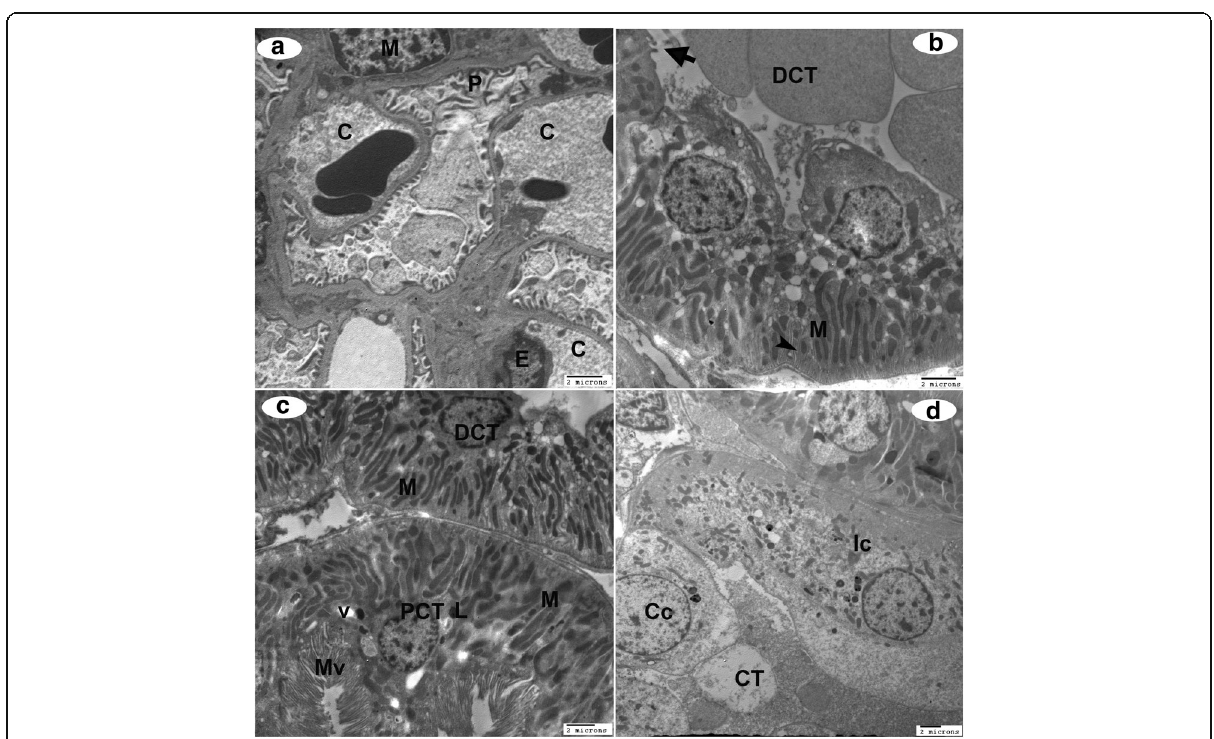
Fig. 2 Electron micrographs of the control rat cortex. a Glomerulus with several capillary loops (C), mesangial cell with dense matrix (M), and several podocyte processes (P) and endothelia cell nucleus (E). b DCT with elongated mitochondria (M), basal enfolding (arrow head), and very few microvilli (arrow). c PCT with characteristic microvilli (Mv), elongated mitochondria (M) in between the basal enfolding, lysosomes (L), and vacuoles (V). d CT with poorly stained clear cell (Cc) and more electron dense intercalated cell (Ic). Scale bar = 2 μ